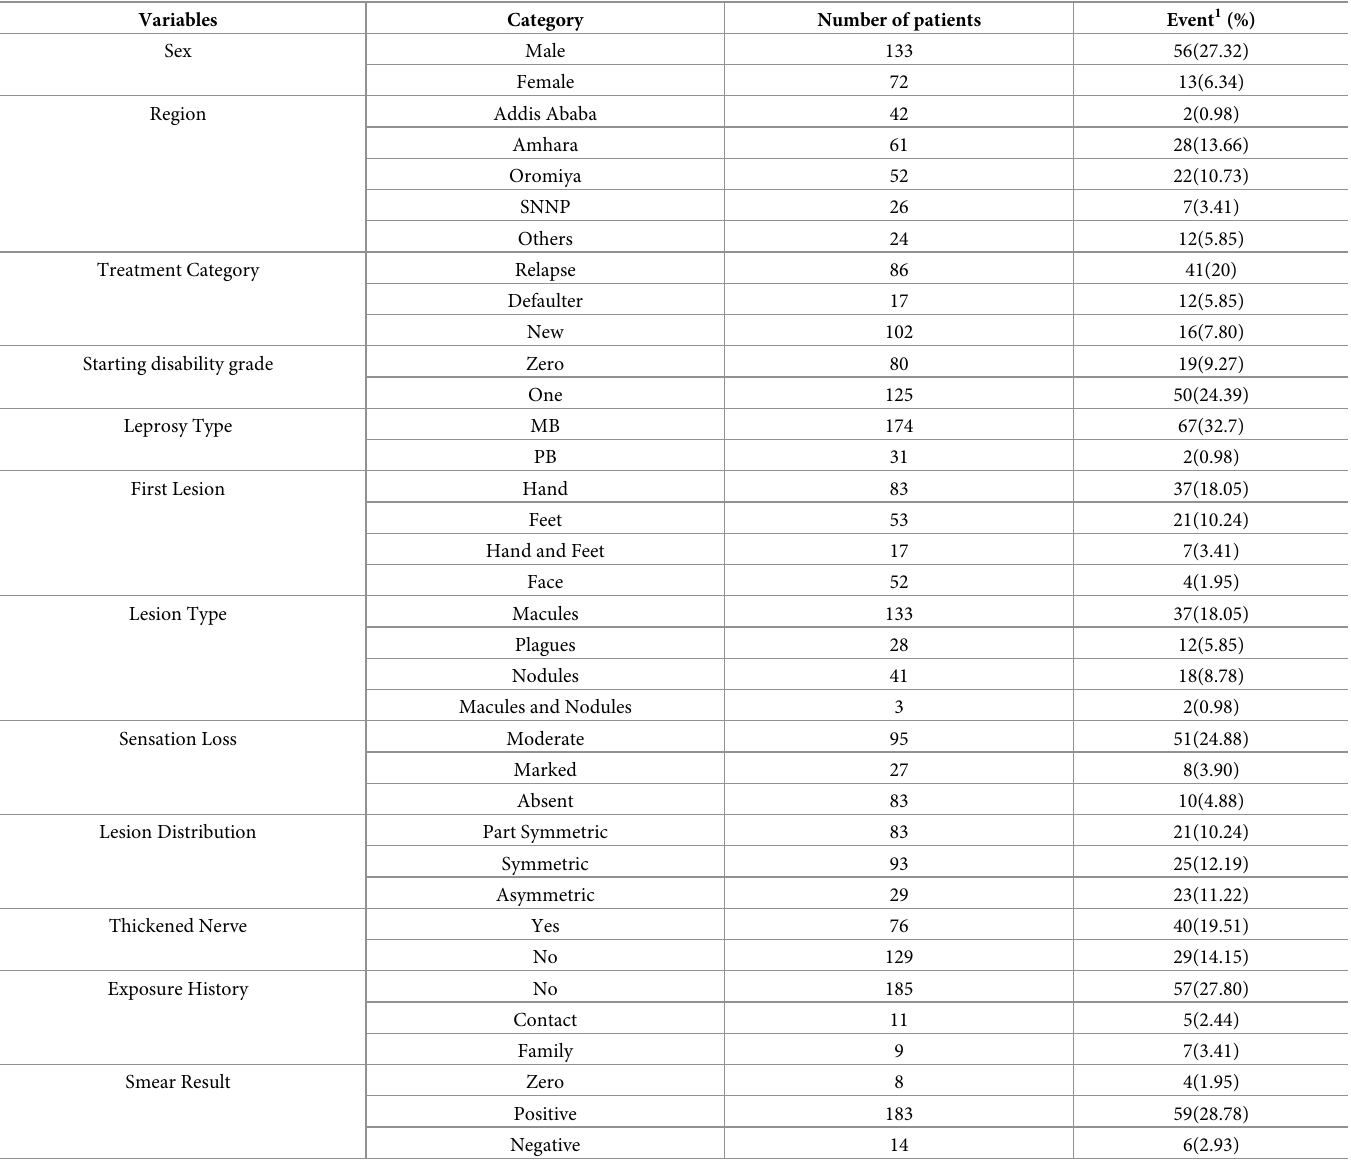
Table 2. Descriptive summary of categorical variables for leprosy patients dataset, LPAC,